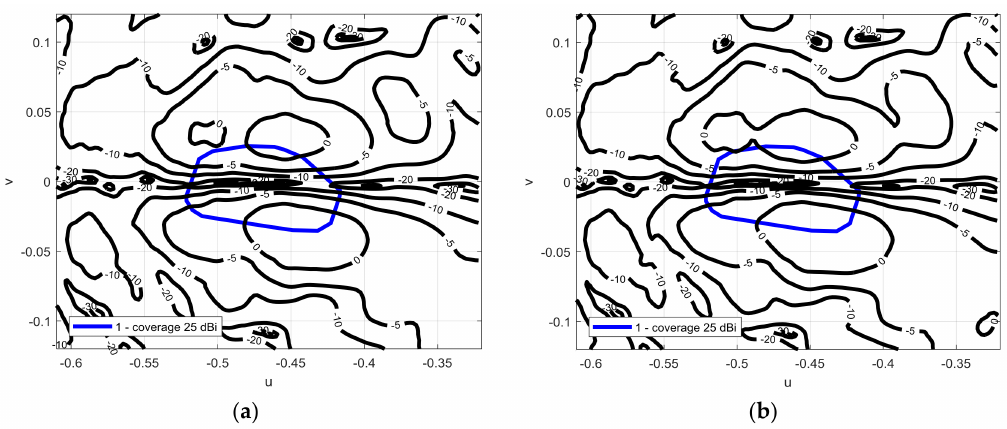
Figure 8. ( a ) Measured contoured plots of the cross-polar components of the radiation pattern (solid black line) superimposed to the coverage mask (thicker solid blue line) for vertical polarization at 13.75 GHz; ( b ) for horizontal polarization at 13.75